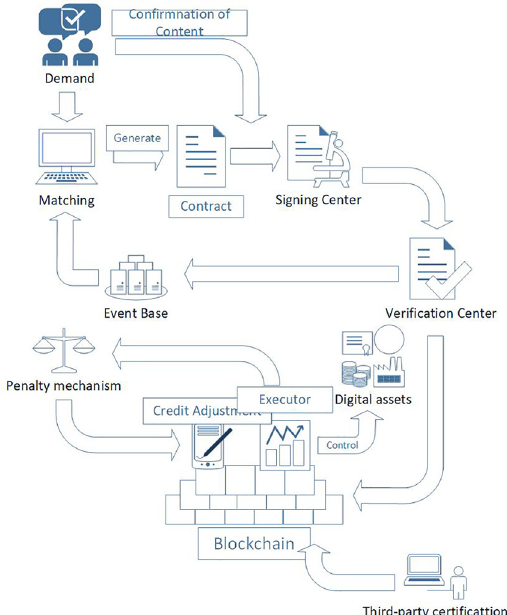
Figure 2. Execution model